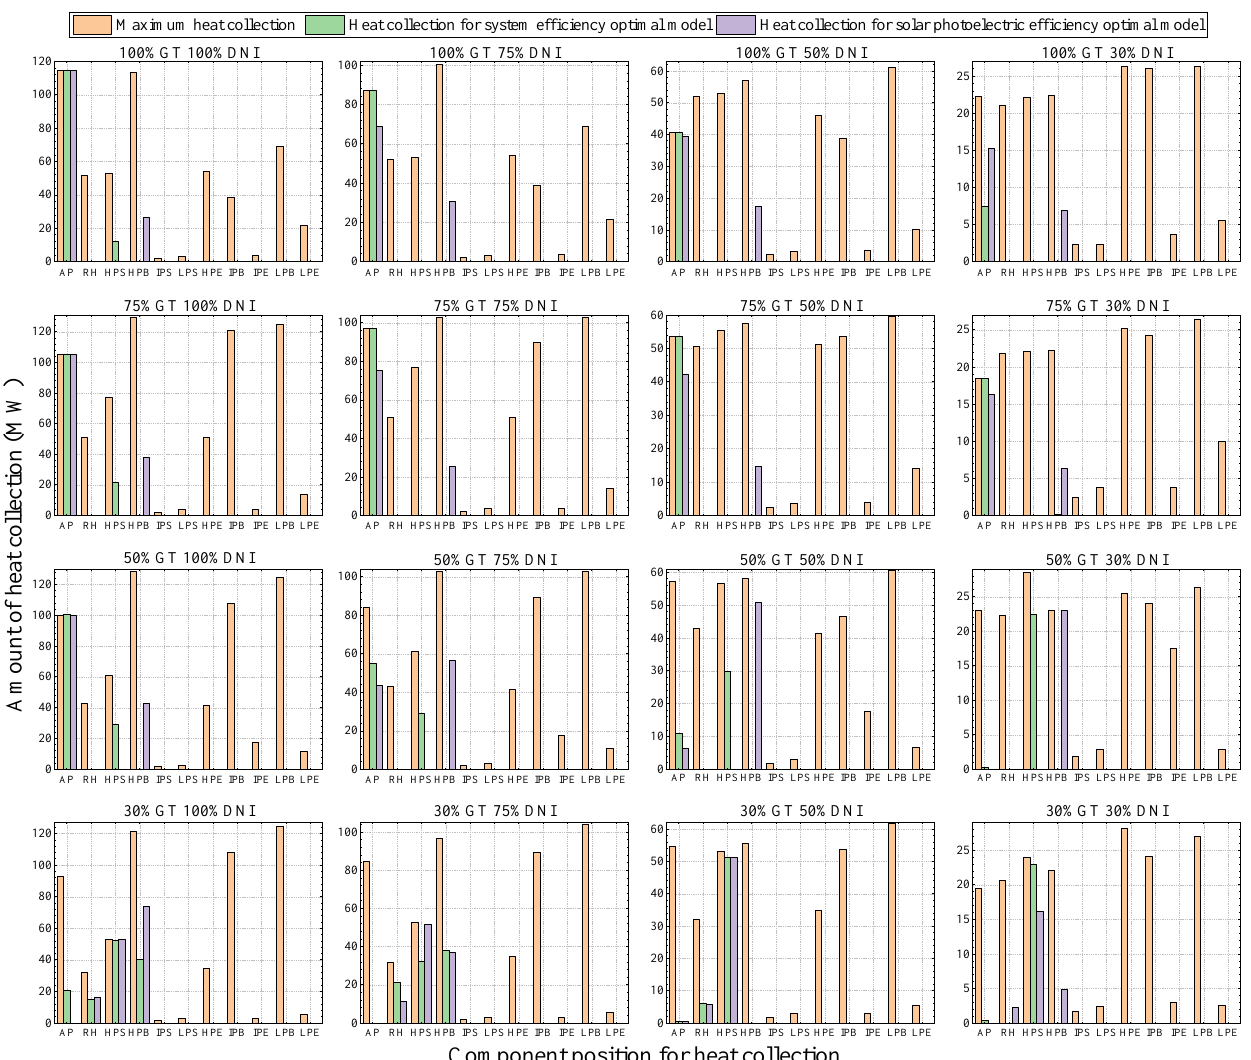
Figure 4. The energy distribution and the maximum integration capacity for each heat exchanger based on the optimal system/solar photoelectric efficiency under different GT load and DNI condi- tions.